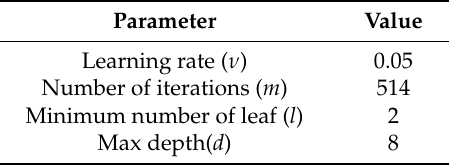
Table 2. Values of parameters for